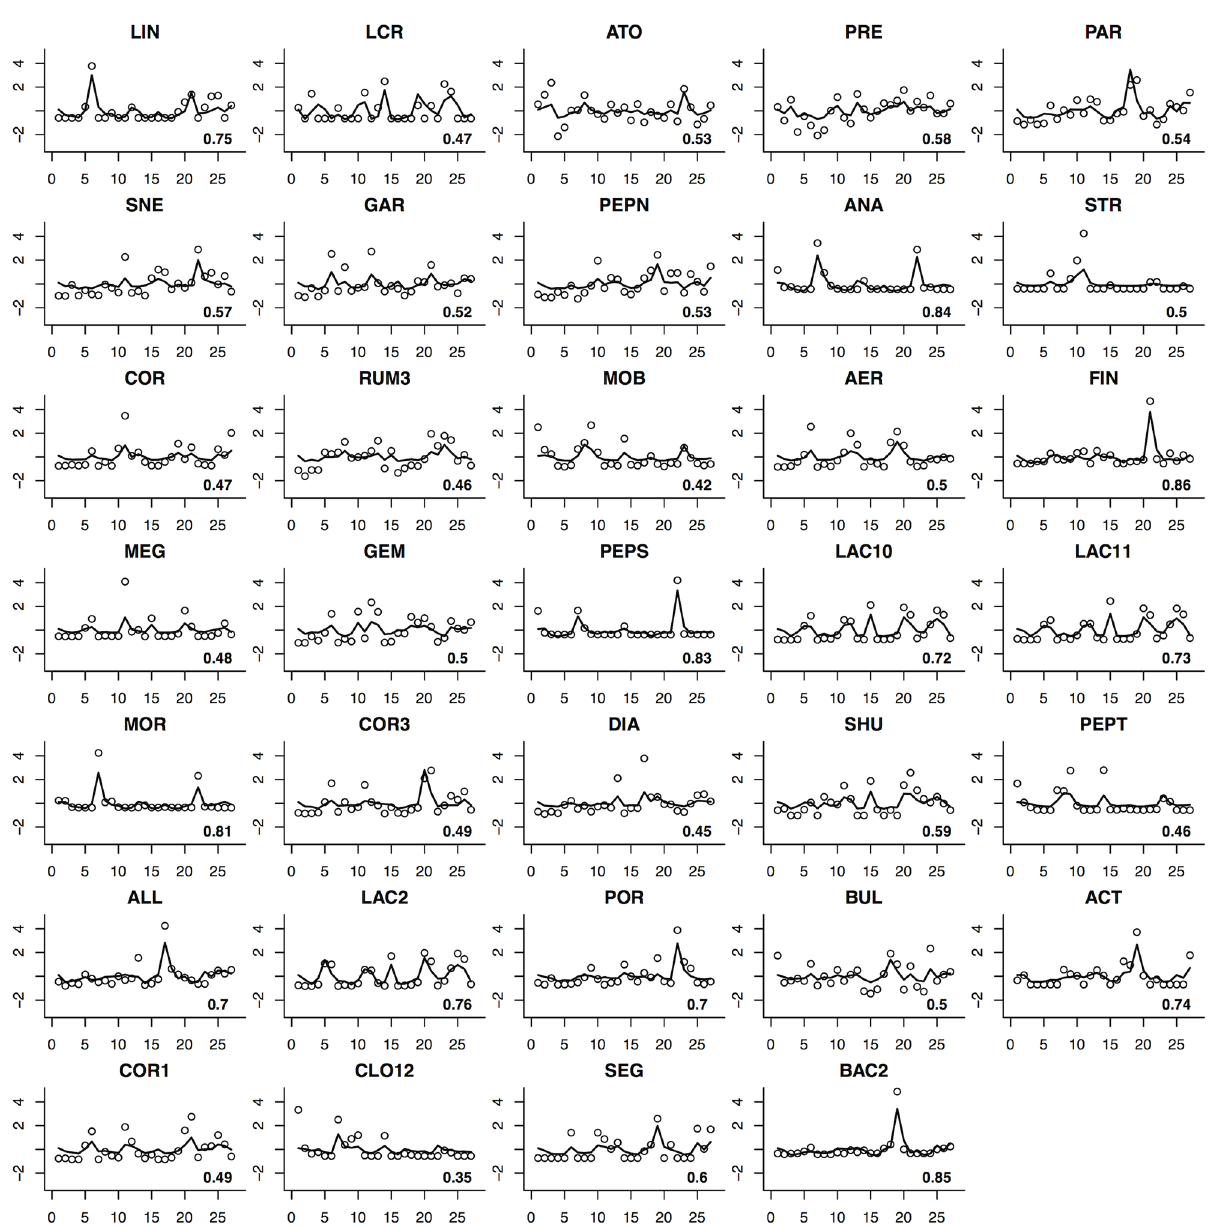
Fig 2. One-step-ahead prediction for subject 6. Each cell represents prediction for a different OTU. Solid lines depict the predictedvalues whereascircles indicatestandardized temporal abundances of OTUs. Abbreviations for Operational Taxonomic Units: LIN Lactobacillus iners ; LCR Lactobacillus crispatus ; ATO Atopobiumsp. ; PRE Prevotella sp. ; PAR Parvimonas sp. ; SNE Sneathiasp. ; GAR Gardnerella sp. ; PEPN Peptoniphilus sp. ; ANA Anaerococcus sp. ; STR Streptococcus sp. ; COR Corynebacterium sp. ; RUM3 Ruminococcaceae3 ; MOB Mobiluncus sp. ; AER Aerococcus sp. ; FIN Finegoldiasp. ; MEG Megasphaera sp. ; GEM Gemella sp. ; PEPS Peptostreptococcus sp. ; LAC2 Lachnospiraceae 10 ; LAC11 Lachnospiraceae 11 ; MOR Moryellasp. ; COR3 Coriobacteriaceae3 ; DIA Dialister sp. ; SHU Shuttleworthia sp. ; PEPT Peptococcus sp. ; ALL Allisonellasp. ; LAC10 Lachnospiraceae 2 ; POR Porphyromonas sp. ; BUL Bulleidiasp. ; ACT Actinomyces sp. ; COR1 Coriobacteriaceae1 ; CLO12 Clostridiales 12 ; SEG Segniliparus sp. ; BAC2 Bacteroidales 2 .